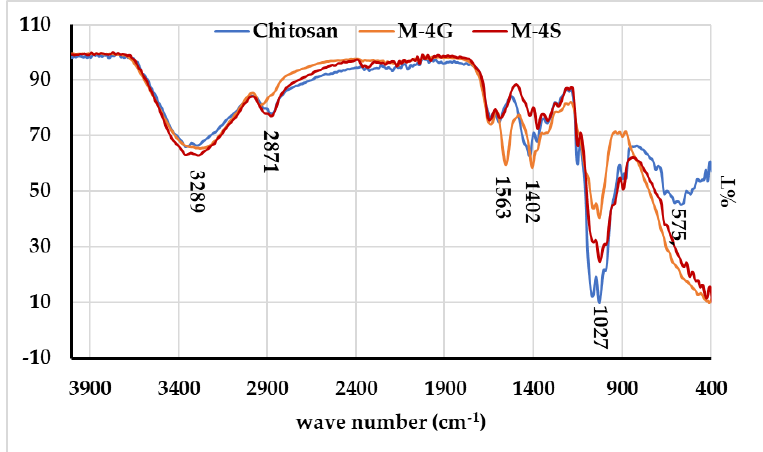
Figure 3. Voltammograms of cyclic voltammetry for p -AP solution in pH 6.2 buffer on SPCE-unmodified, SPCE-M-4G, and SPCE-M-4S.